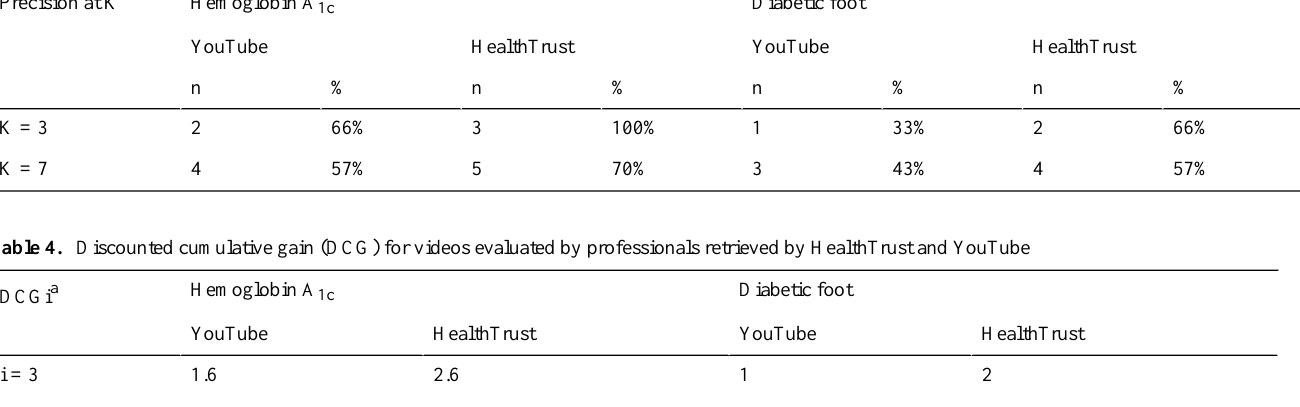
Diabetic footHemoglobin A 1c Precision at K